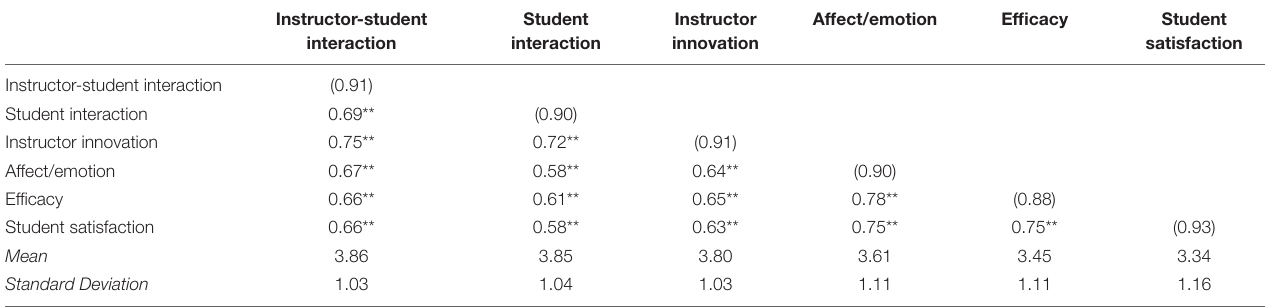
TABLE 3 | Descriptive statistics, reliabilities and correlations of the factors ( N =